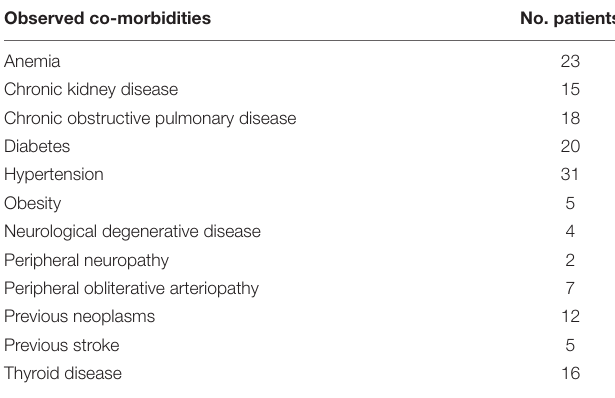
TABLE 1 | Breakdown of patients based on the most frequent